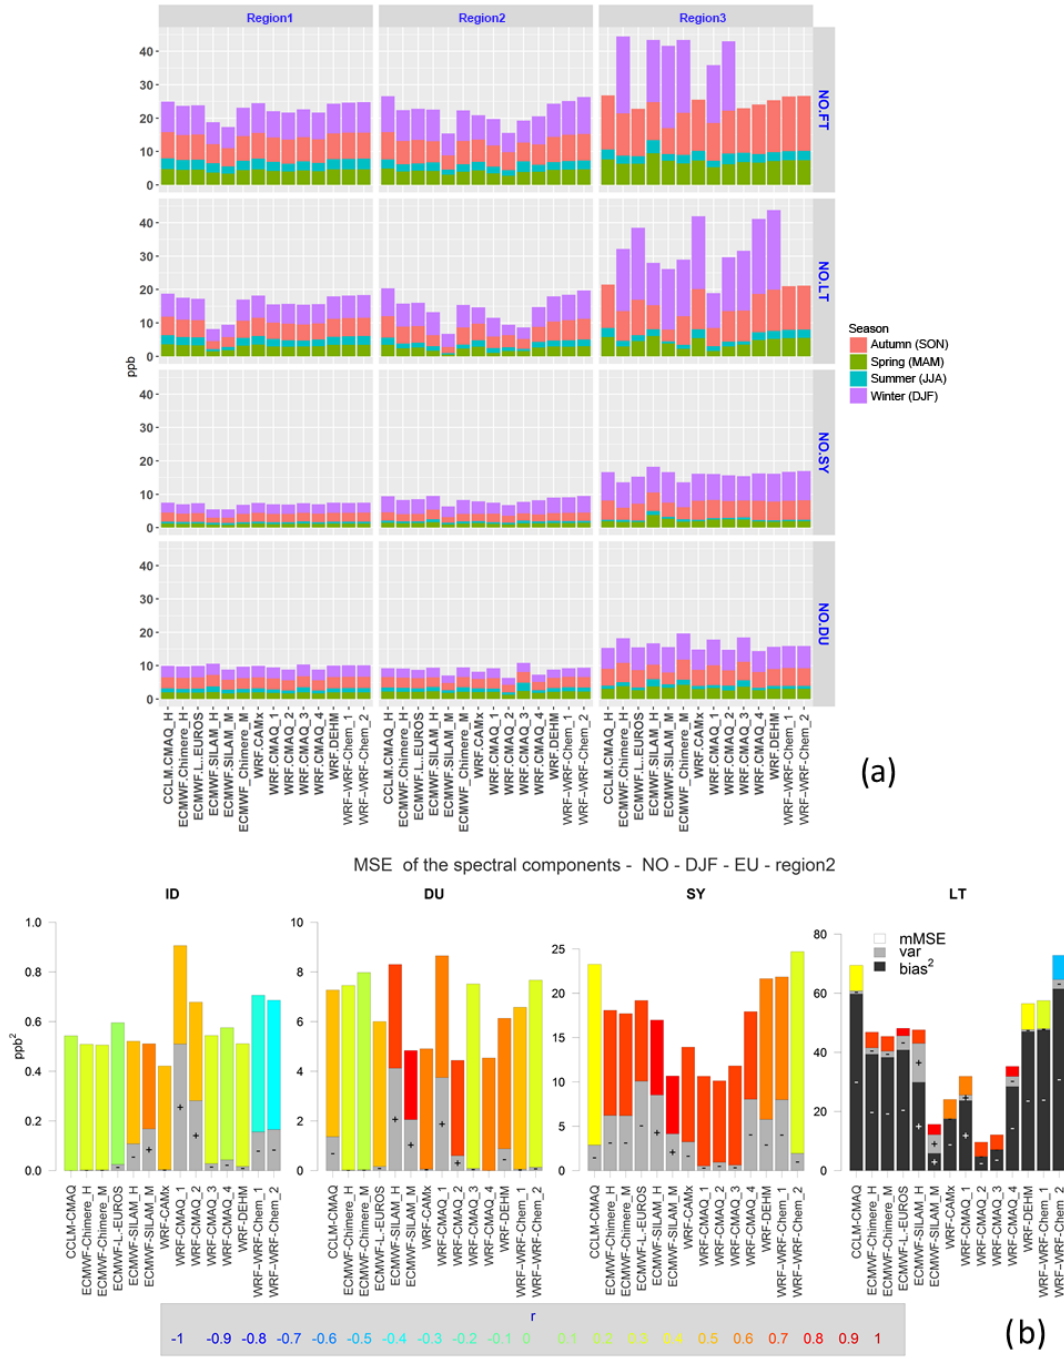
Figure 12. Top panel is as in Fig. 9 but for NO (EU only). Lower panel is as in Fig. 10 but for NO (EU only).